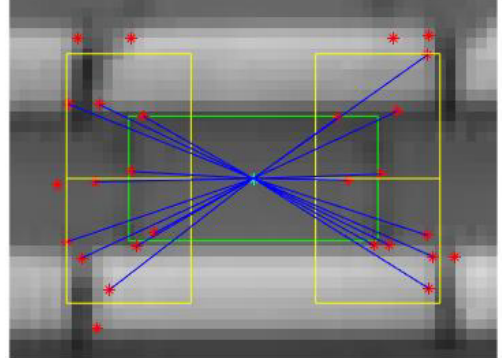
Figure 2. Template solar cell. Red crosses are detected Förstner points. Green rectangle is the shape of the cell. Yellow squares are the local neighborhoods of the cell corners to keep detected Förstner points. Distances are calculated for the Förstner points inside the yellow squares and visualised as blue lines.